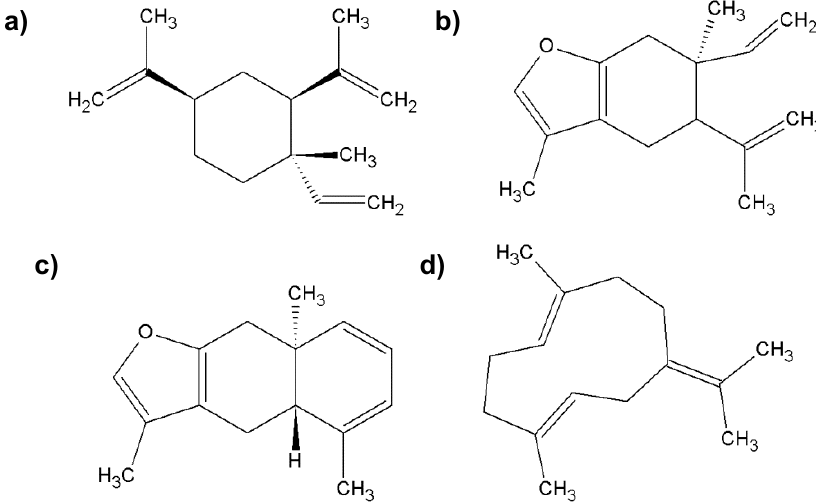
Figure 4. The most important chemical compounds found in myrrh; ( a ) β -elemene; ( b ) curzerene; ( c ) furanoeudesma-1,3-diene; ( d ) germacrene-B.